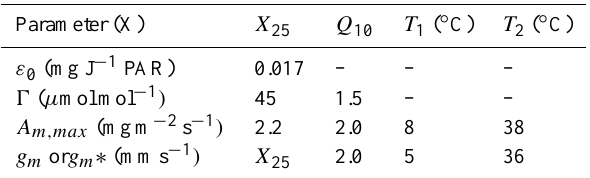
Table 2. Typical values of the variables of the A-gs model for C3 plants, and temperature response. Note that ε 0 is the maximum quantum use efficiency, 0 the compensation point, A m,max the maximum net assimilation of the leaf, and g m the mesophyll con- ductance (* denotes unstressed soil moisture conditions). The tem- perature dependence of 0 is described by means of a Q 10 response − 25 )/ 10 function X(T s ) = X( @25 )Q (T s . T 1 and T 2 denote tem- 10 peratures that enable a description of temperature inhibition char- − 25 )/ 10 acteristics: X(T s ) = X( @25 )Q (T s